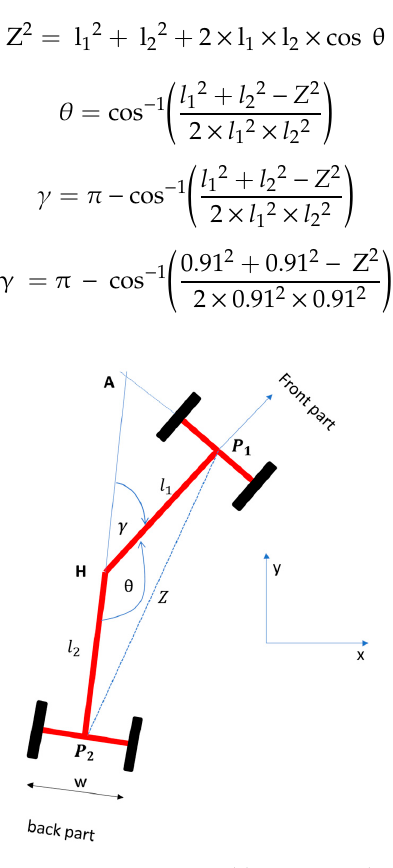
Figure 4. Potentiometer Calibration. Potentiometer calibration involves measurements of the voltage reported by the potentiometer in relation to the changing angle θ of the rover when turning left or right. Assume all the points are in a cartesian coordinate system.